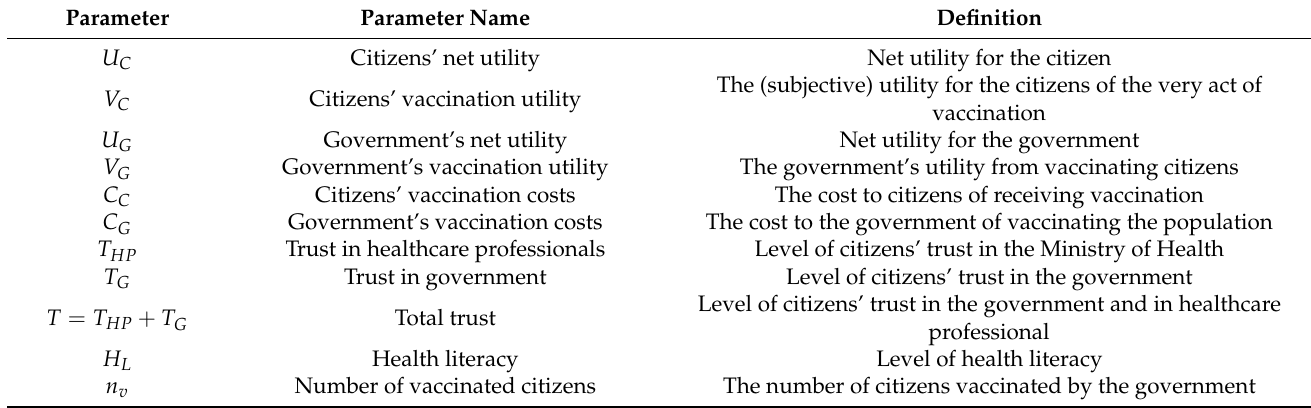
Table 2. Variables and